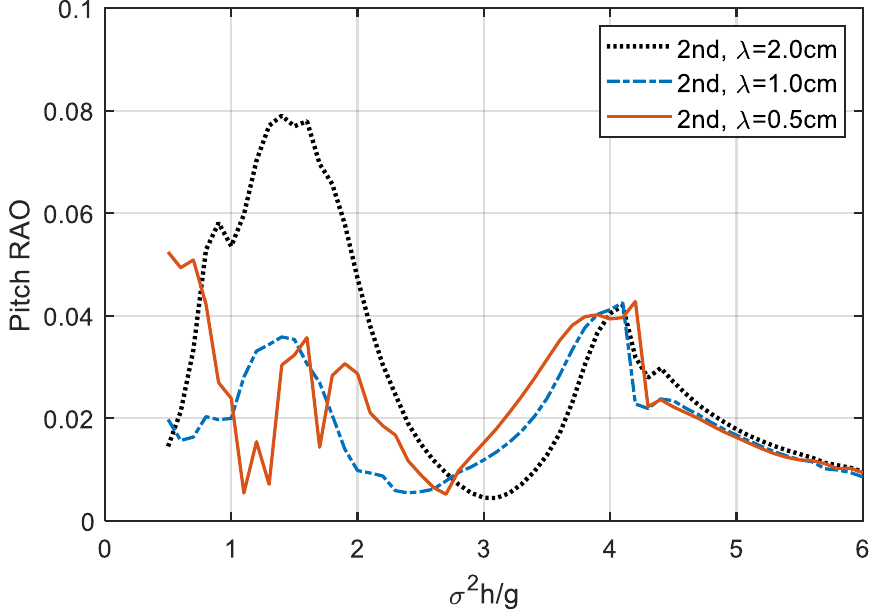
Figure 14. Comparison of the second-order pitch RAO of the floating platform with different fishnet mesh sizes.